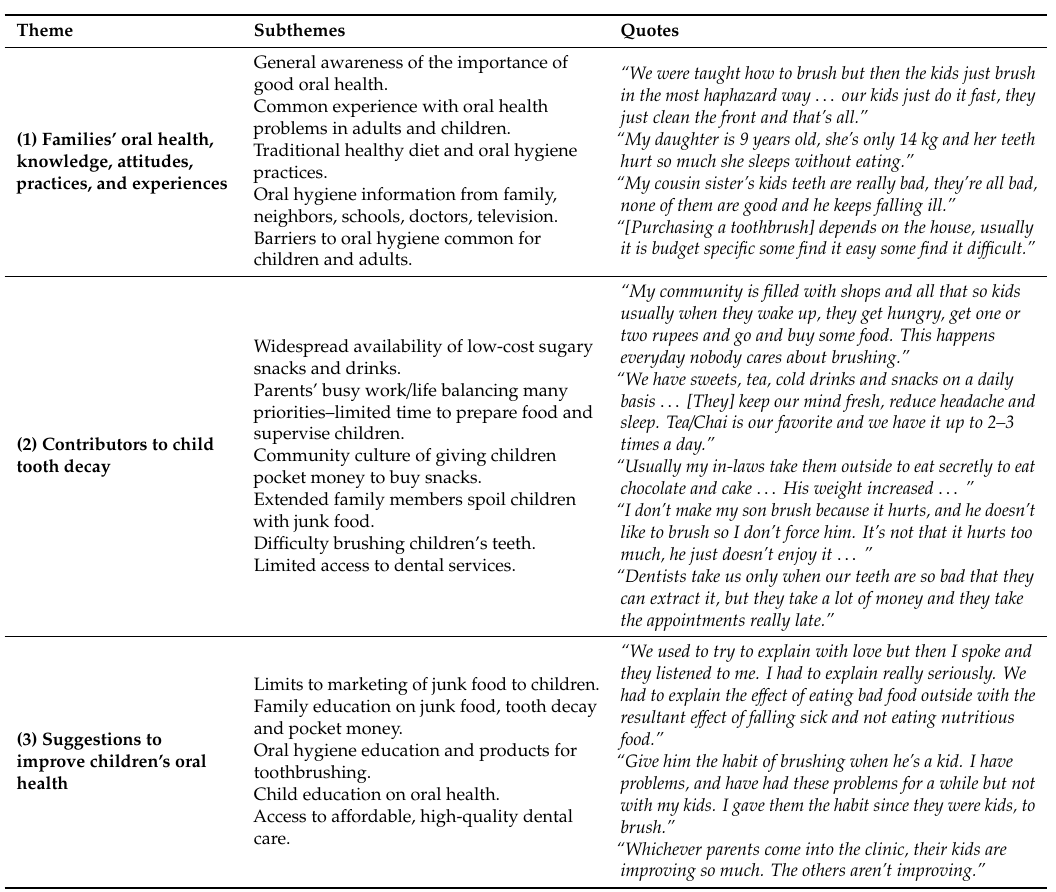
Table 6. Focus Group Themes and